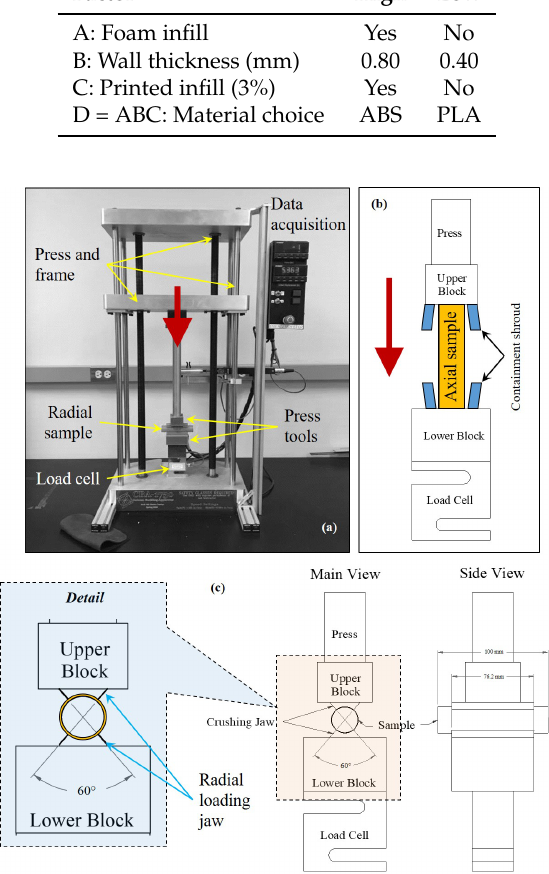
Figure 4. ( a ) Setup and testing apparatus with diagrams for ( b ) axial and ( c ) angled radial loading.